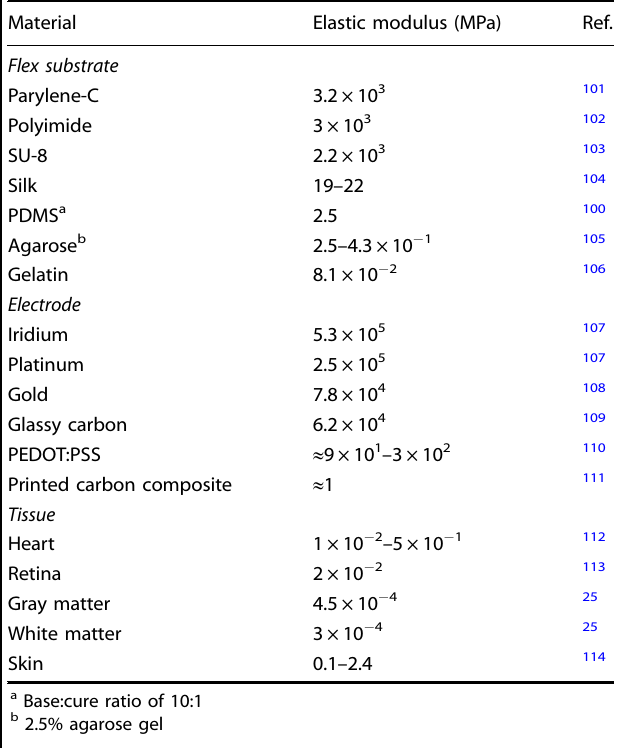
Table 1. Summary of the elastic modulus of fl exible substrates, electrodes, and tissue Material